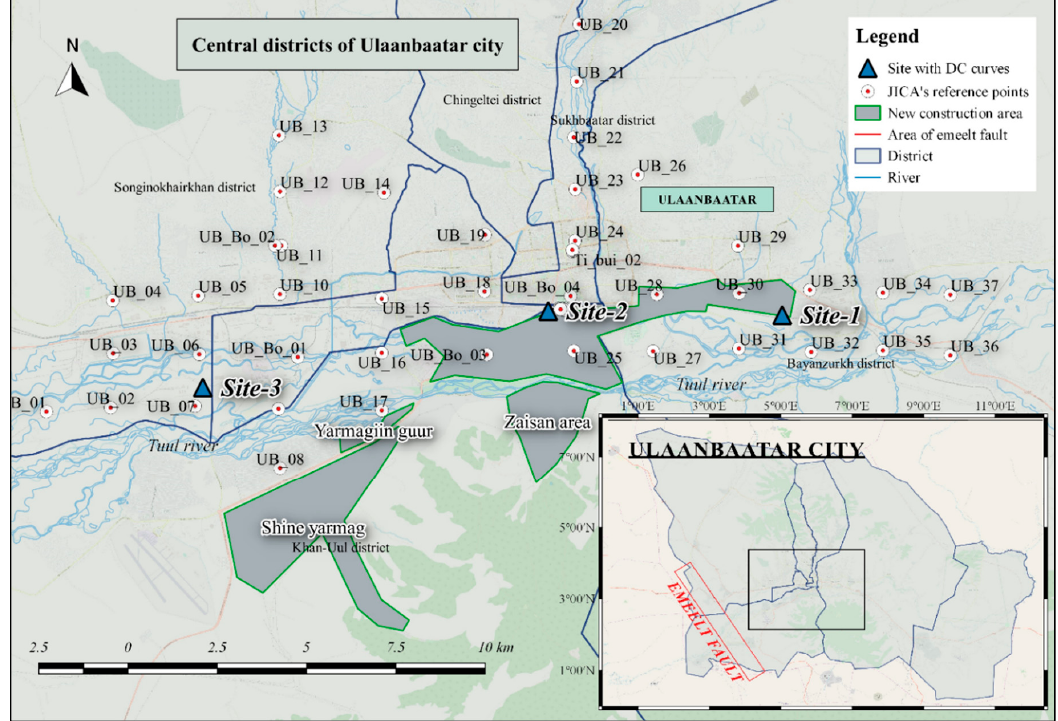
Figure 1. Location map of the study area with Japan International Cooperation Agency’s (JICA) report reference sites and the location of the Emeelt fault.